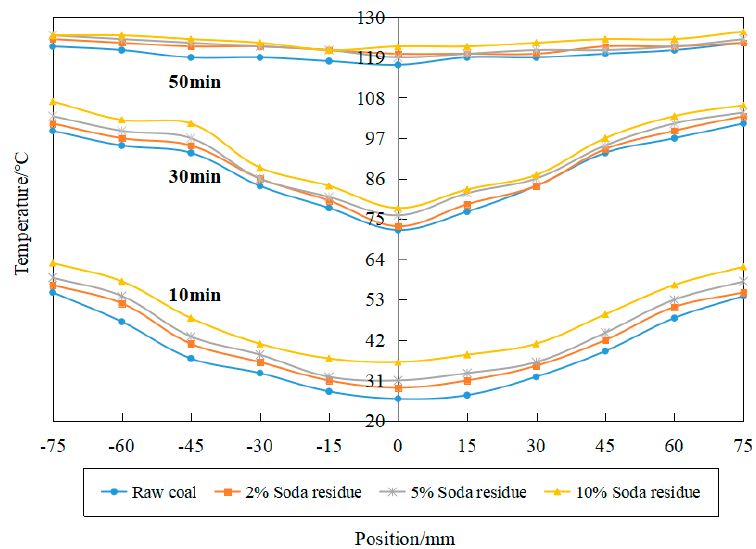
Figure 8. Effects of additives on temperature transfer from edge to center in coal.